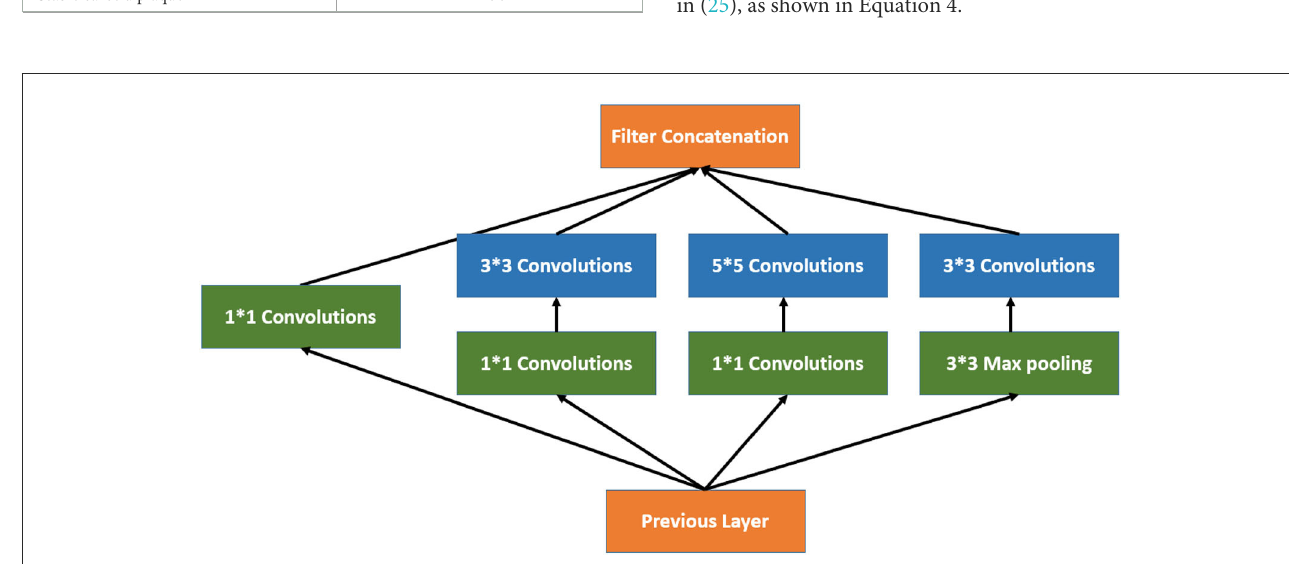
FIGURE3 Architecture of inception